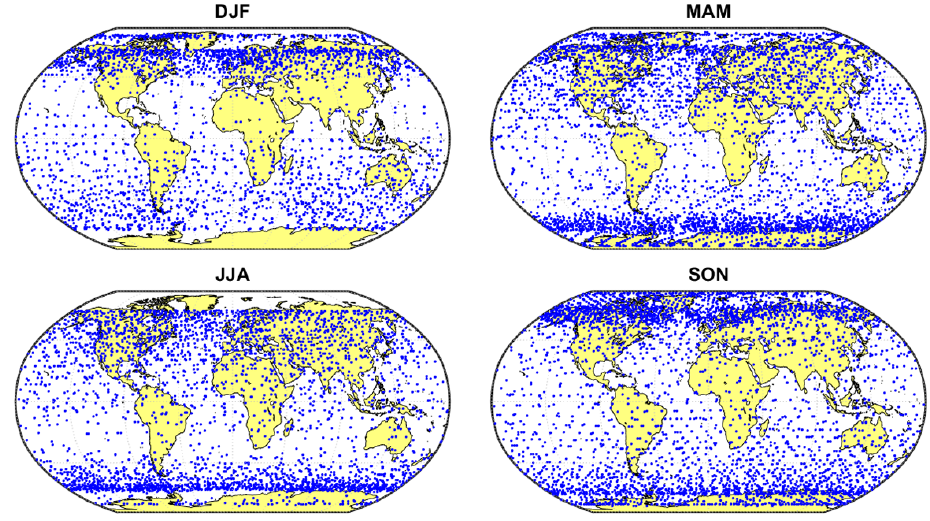
Figure 2. Location of all ACE CH 4 measurements by